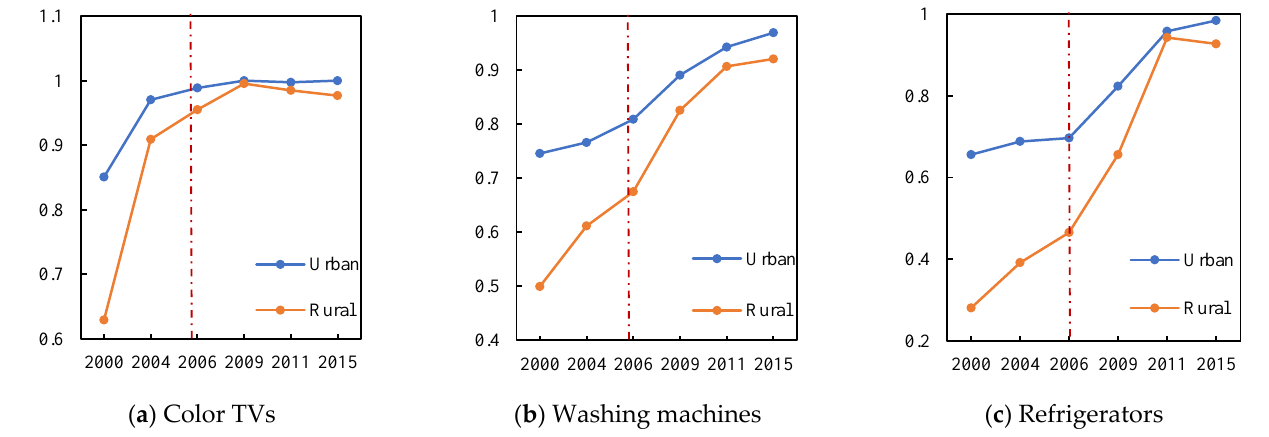
Figure 1. Adoption rate for household appliances before and after the HAGC policy implementa- tion.